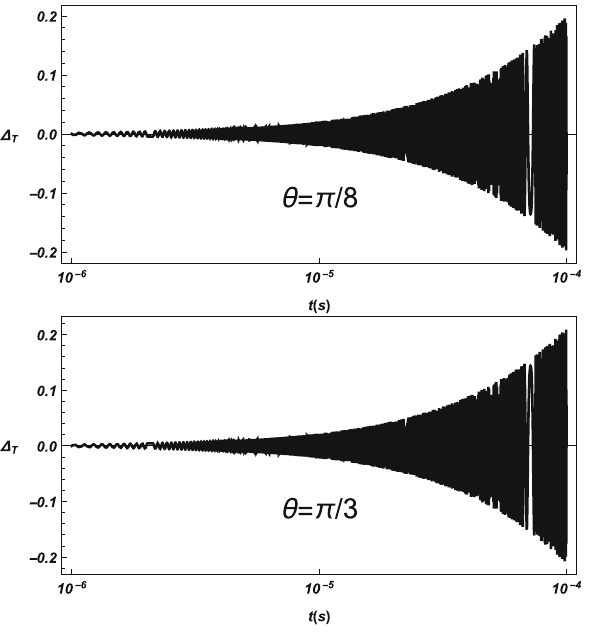
Fig. 8 Plots of (cid:14) T ( t ) for different choices of θ for a set-up with n = 8 trappedions.ThesameparametersasFig.7areused.Weusedadifferent timescale to better highlight the T